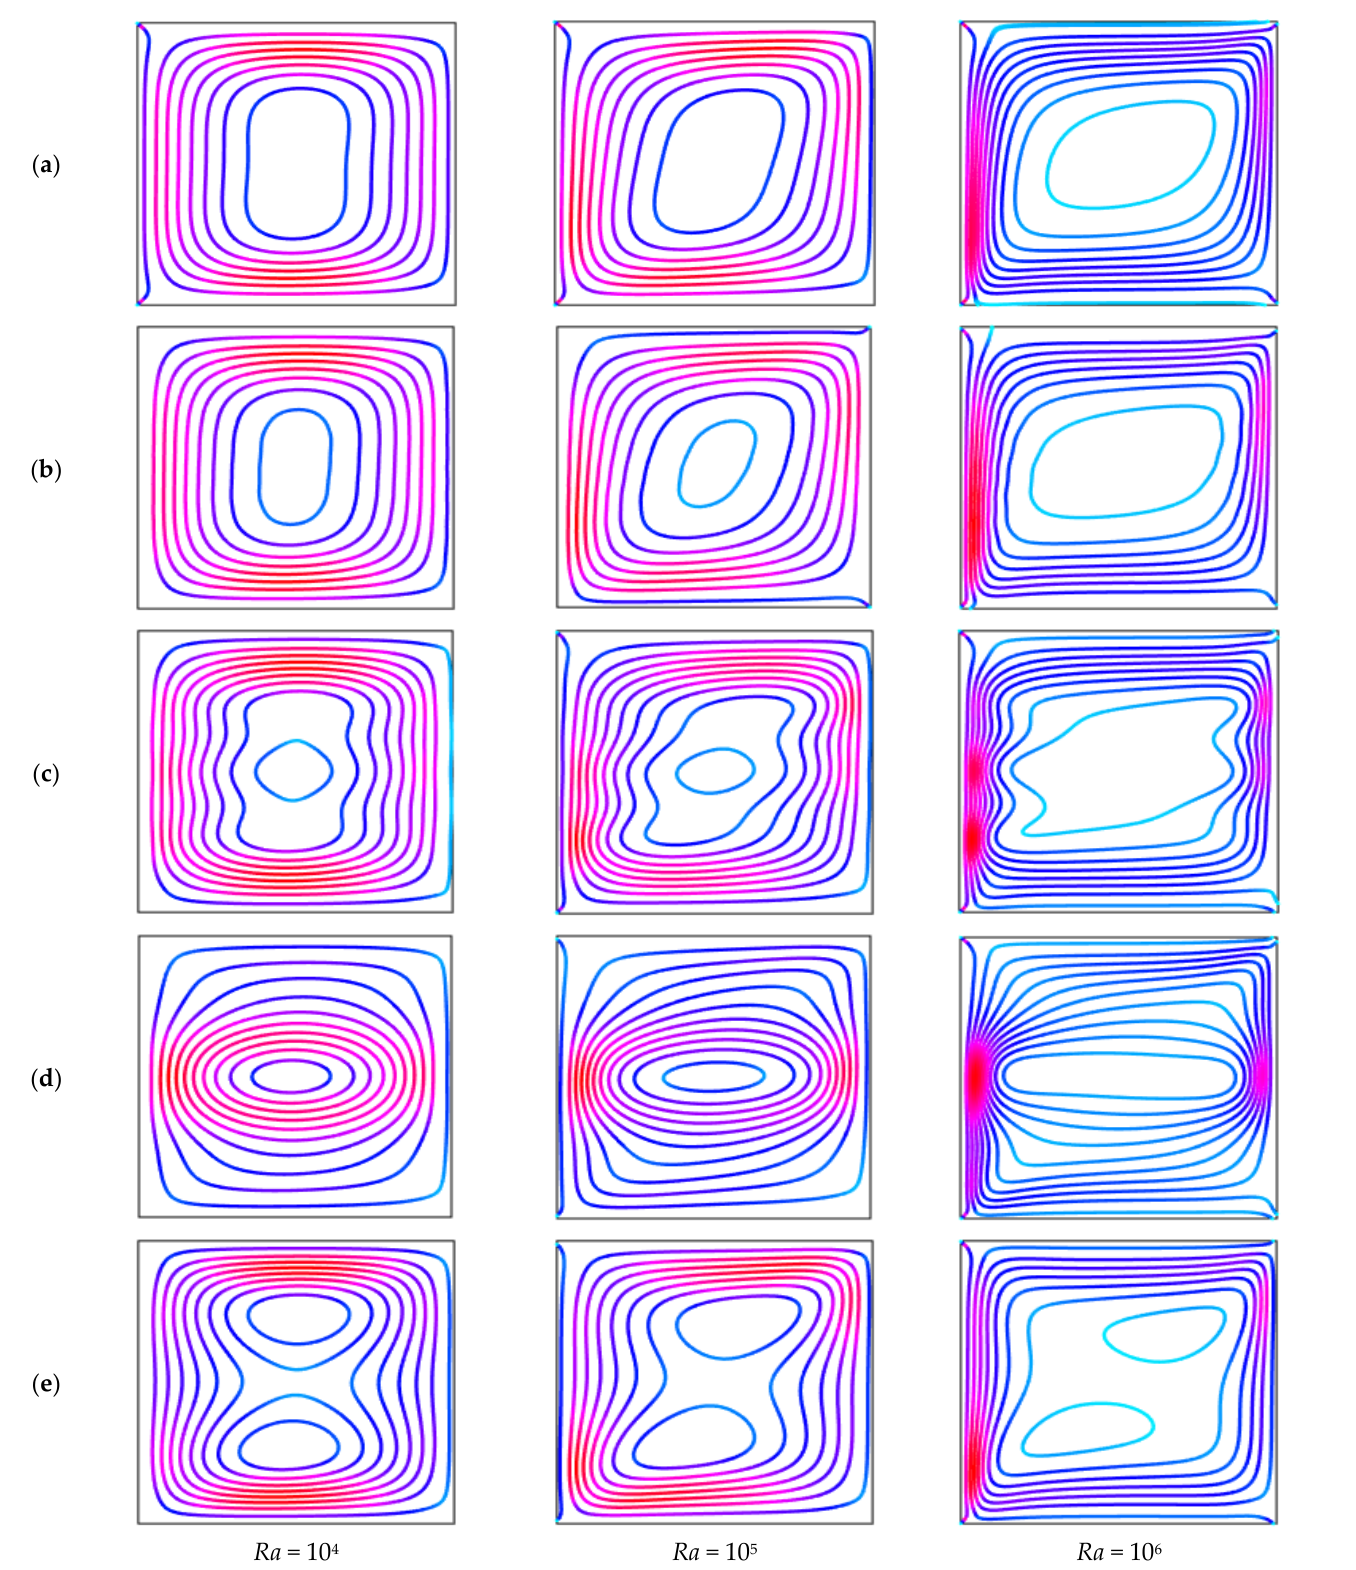
Figure 5. Effect of streamline contours for various Rayleigh number ( Ra ) for ( a ) uniform magnetic field (umf), ( b ) λ = 0.1, ( c ) λ = 0.25, ( d ) λ = 0.5, and ( e ) λ = 1 when Ha = 30, d = 10 nm, ϕ = 0.04, n = 3, Pr = 6.8377, and τ = 1.